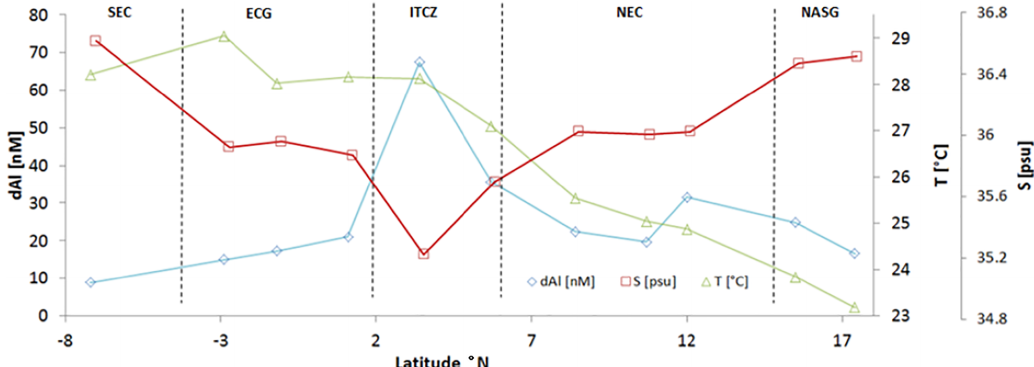
Figure 4. Distribution of dAl (nM), salinity and temperature for the northward transect in the tropical Atlantic (GA06). SEC, South Equatorial Current; ECG, Equatorial Gyre; ITCY, Intertropical Convergence Zone; NEC, North Equatorial Current; NASG, North Atlantic Subtropical Gyre.